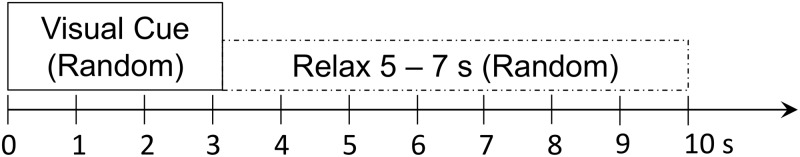
Experimental paradigm.At 0 s, a visual cue is randomly selected and presented. After 3 s, a blank screen appears for 5 −7 s before another visual cue is presented. During this period of time, the participant is requested to rest.